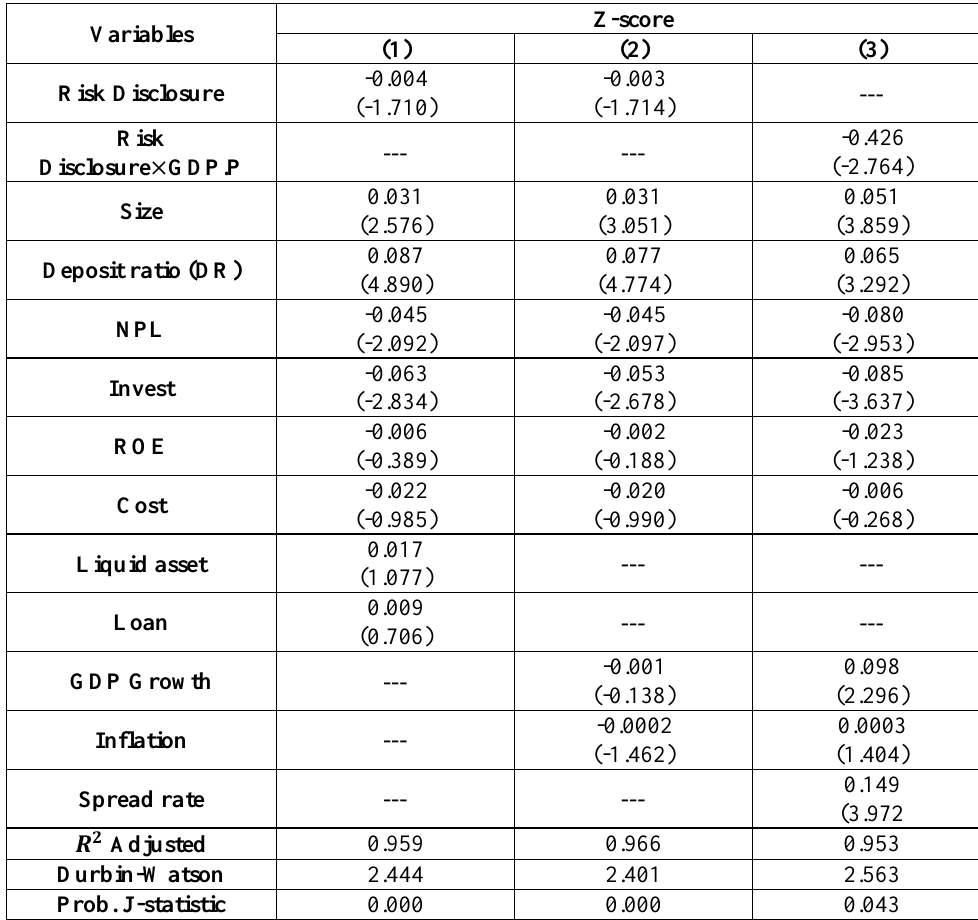
Table 5. Estimation of a regression